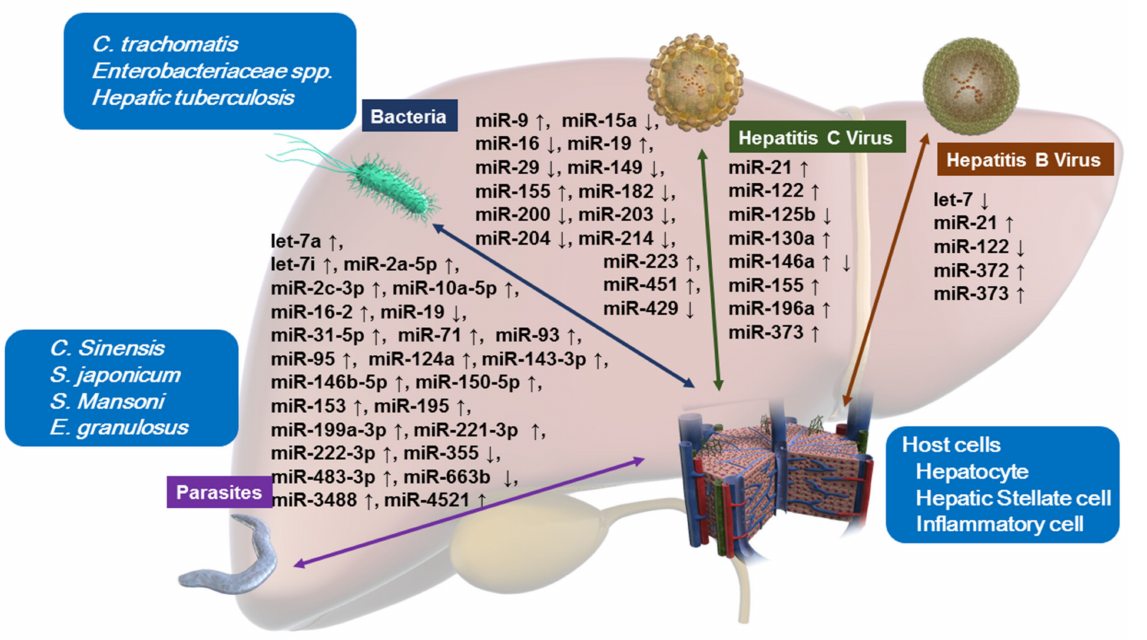
Figure 1. Altered miRNA expressions upon host–pathogen interactions in hepatocytes, hepatic stellate cells, and inflamma- tory cells. Bacteria: Chlamydia trachomatis , Enterobacteriaceae spp., Mycobacterium tuberculosis (hepatic tuberculosis). Parasites: Clonorchis sinensis , Schistosoma japonicum , Schistosoma mansoni , Echinococcus granulosus . Table 1. Altered miRNA expressions in various infectious liver